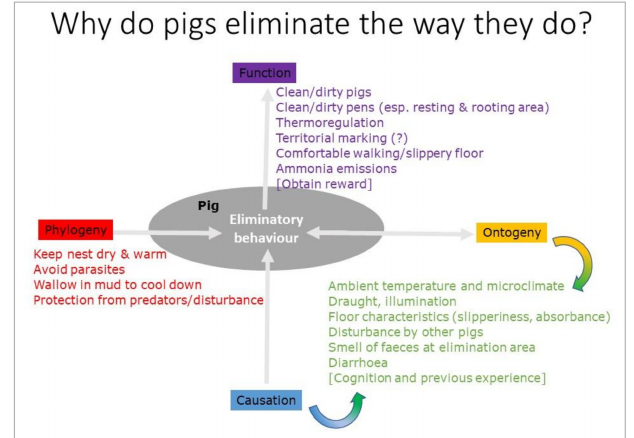
Figure 1. Visual summary of the application of Tinbergen’s framework to explain eliminatory behaviour in pigs in terms of its phylogeny, ontogeny, causation, and